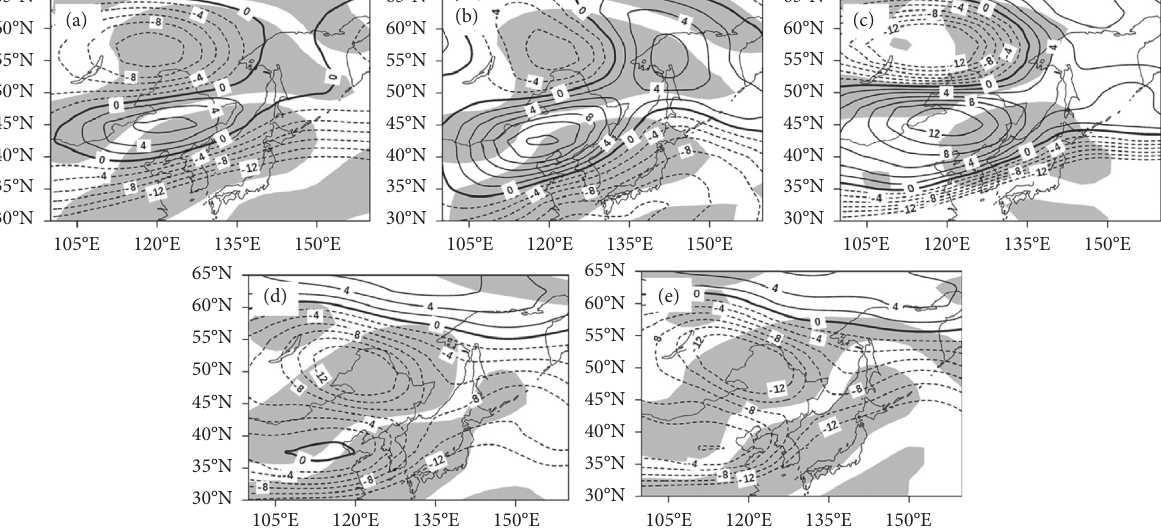
Figure 8: Composite anomaly fields of 300 hPa zonal wind (unit: m · s − 1 ) for NCVs in (a) May to September, (b) late spring, and (c) early autumn, and for MCVs in (d) May to September and (e) summer. The solid and dashed contours indicate positive and negative anomalies of zonal wind speeds, respectively. Areas with grey color are those reaching the 95% significance